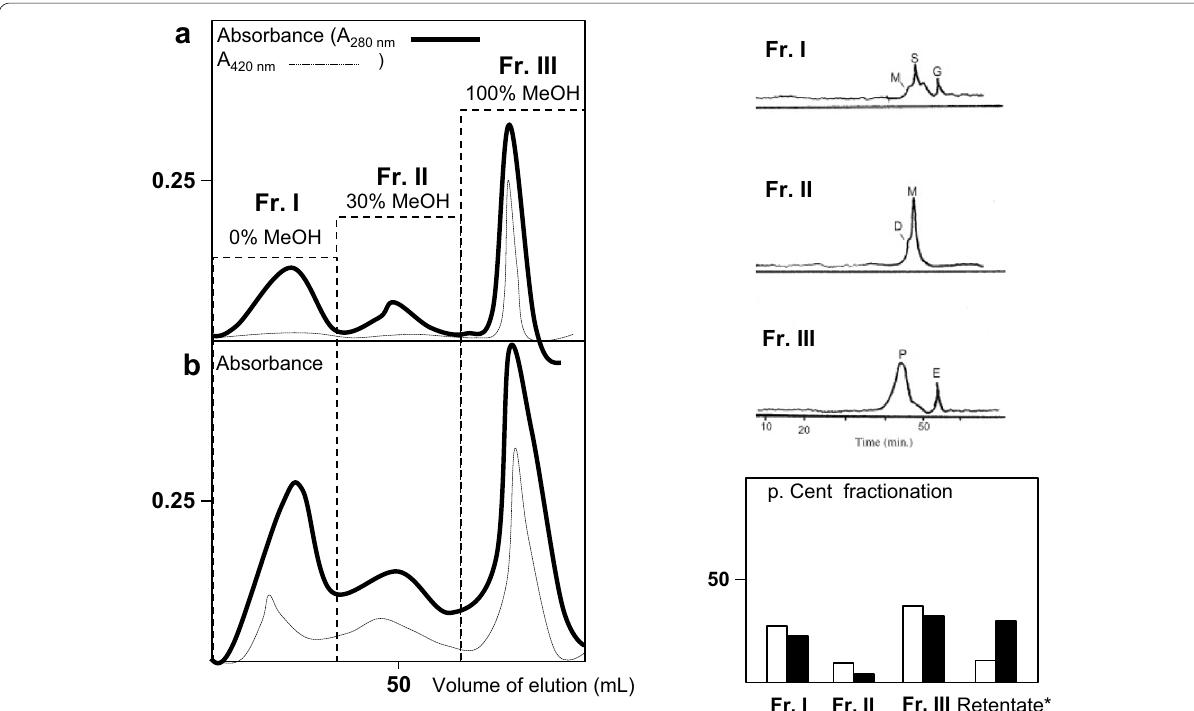
Fig. 2 Example of fractionation of and characterisation of extractable oak heartwood colour. Firstly pre‑fractionation is obtained by low‑pressure chromatography on Sephadex LH20‑100 column (20 2 cm, flow rate, 3.5 mL/mn, detection 280 nm for phenols and 420 nm for colour) of oak × acetone/water (7/3) extract (1 g of dry wood/100 mL solvent). Fraction I was obtained by water elution, fraction II, by 30% MeOH and Fraction III by 100% MeOH solvent. a Inner heartwood, b outer heartwood. Secondly each pre‑fraction are analysed after acetylation by high‑performance size‑exclusion chromatography (TSK G2000 PW column, 30 7.5 cm, solvent, MeOH 1% H 3 PO 4 , flow rate 0.6 mL/mn, column calibrated by × + gallic acid G, ellagic acid E, castalin, castalagin, roburin D and grandinin). S: vescalin, castalin; M: monomer ellagitannins; D: dimer ellagitannins;